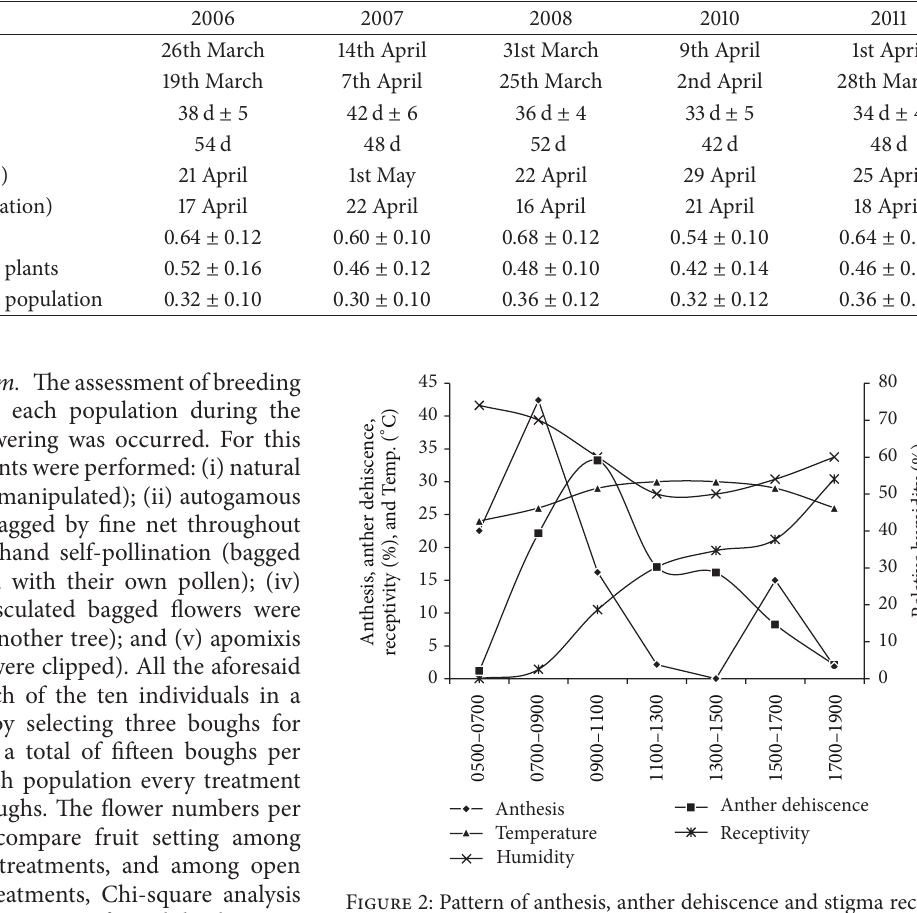
Table 1: Phenology data at the plant and population levels. For plant data, values shown are the mean of all plant values ± standard deviation. For population data, values given represent whole population (i.e., the onset is the date of the first flower on the first plant in the population). Dates are given in the calendar date.